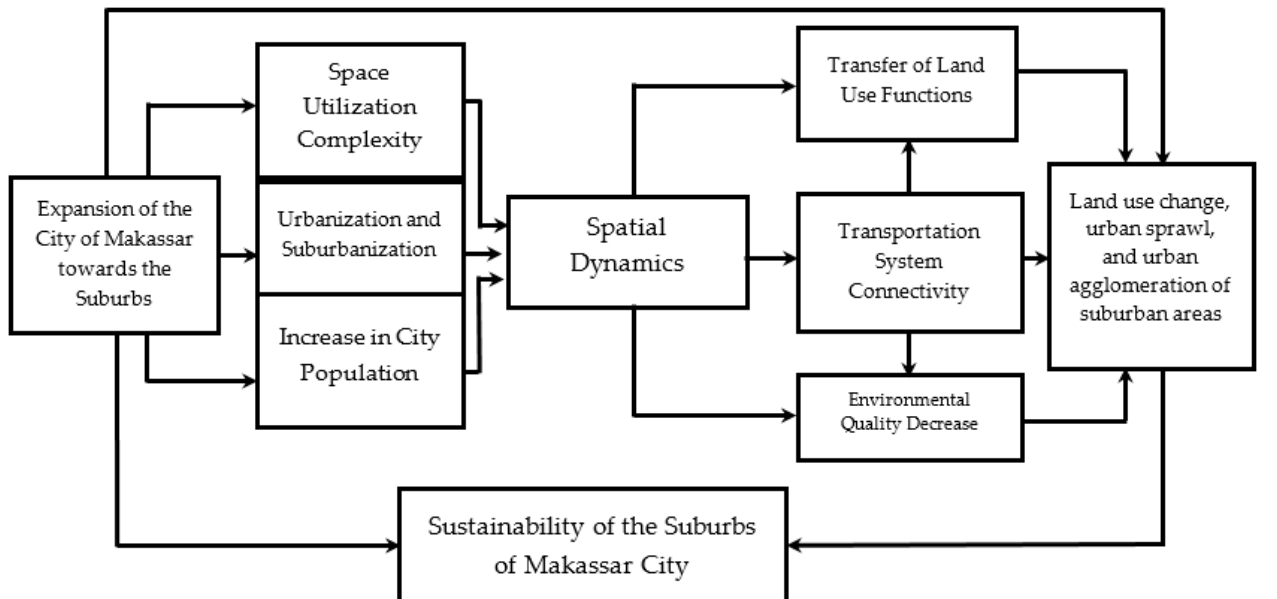
Figure 1. Conceptual framework of urban spawl and land-use change in Makassar City. Source: Author elaborator.